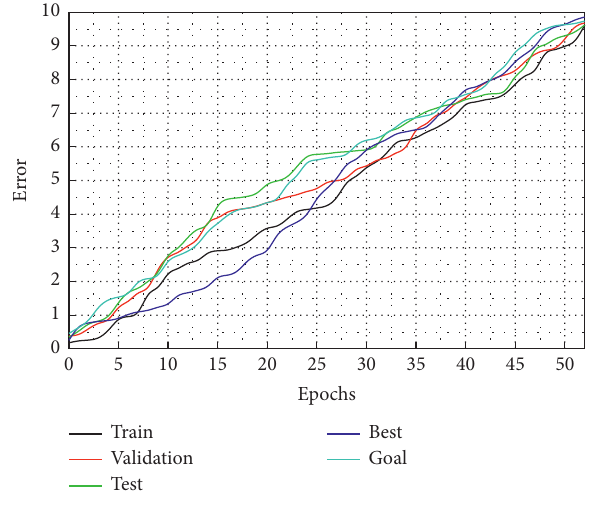
Figure 5: BP neural network fit.